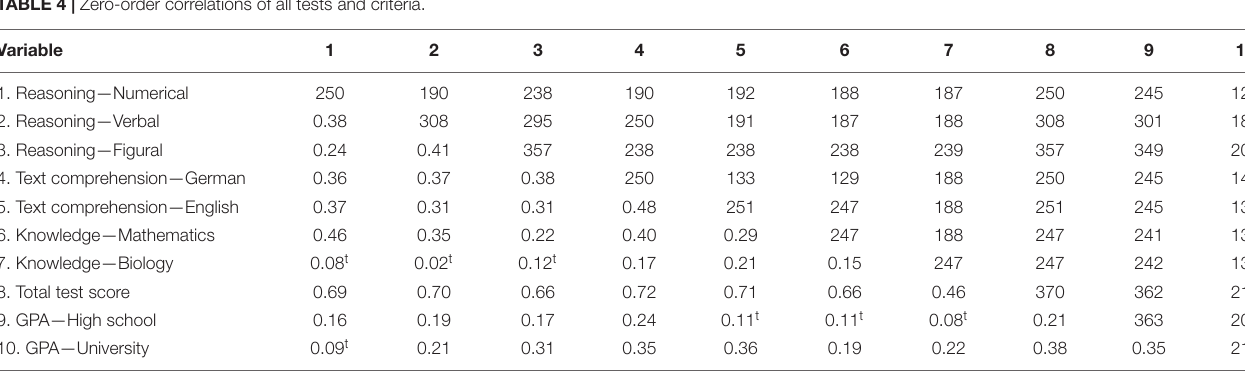
TABLE 4 | Zero-order correlations of all tests and